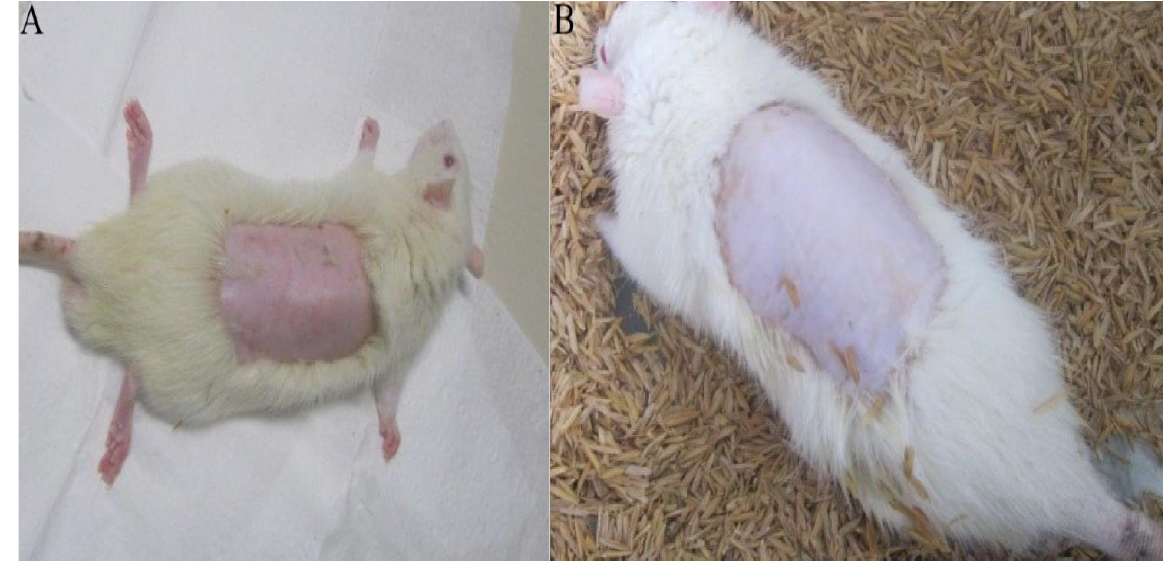
Figure 5. Images showing animal epilation prior to application of hydrogel for dermal toxicity test ( A ) and animal 24 h after hydrogel removal in acute toxicity test ( B ).